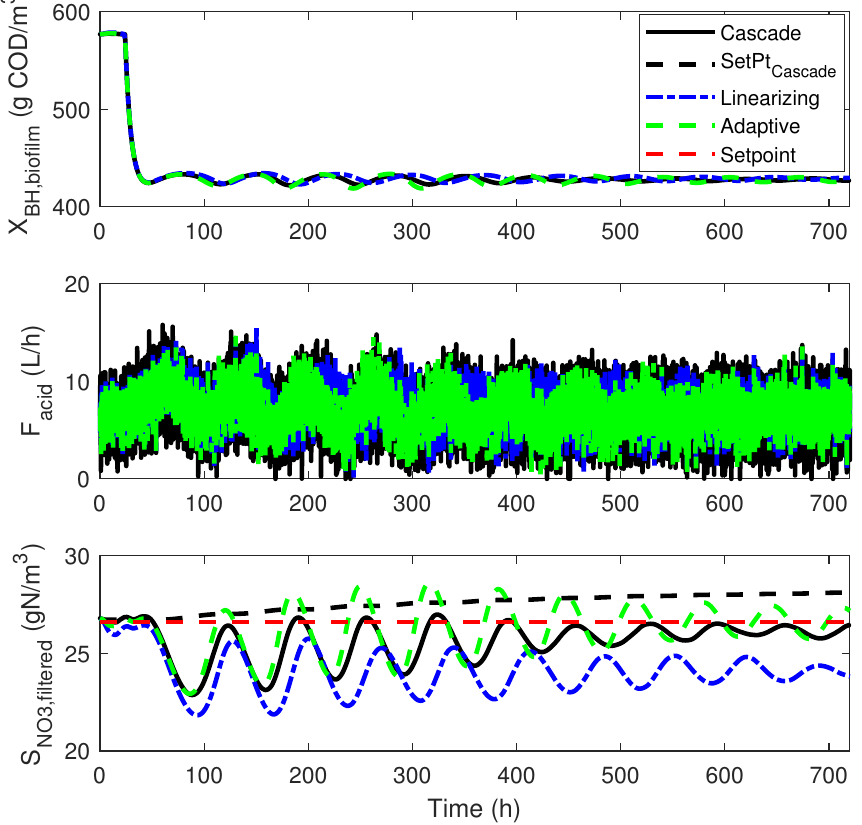
Figure 12. Simulation results obtained for the linearizing, adaptive and cascade controllers when the biomass death rate is increased and a 10% measurement noise on all measured variables ( S NO 3 , S S , S O and X BH ) is added. SetPt Cascade represents the corrected setpoint curve and Setpoint the desired